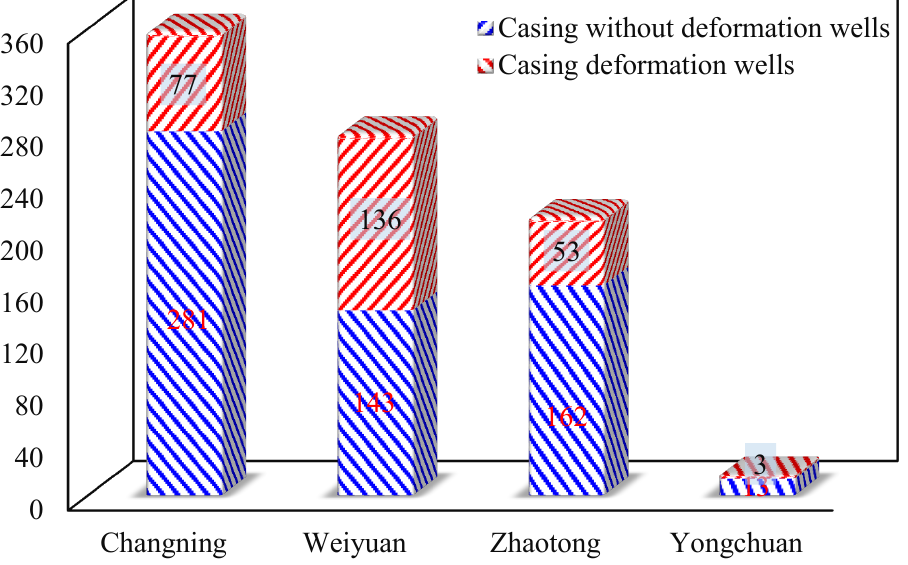
Figure 1. Statistics on casing deformation in some shale gas fields of Sichuan Basin.